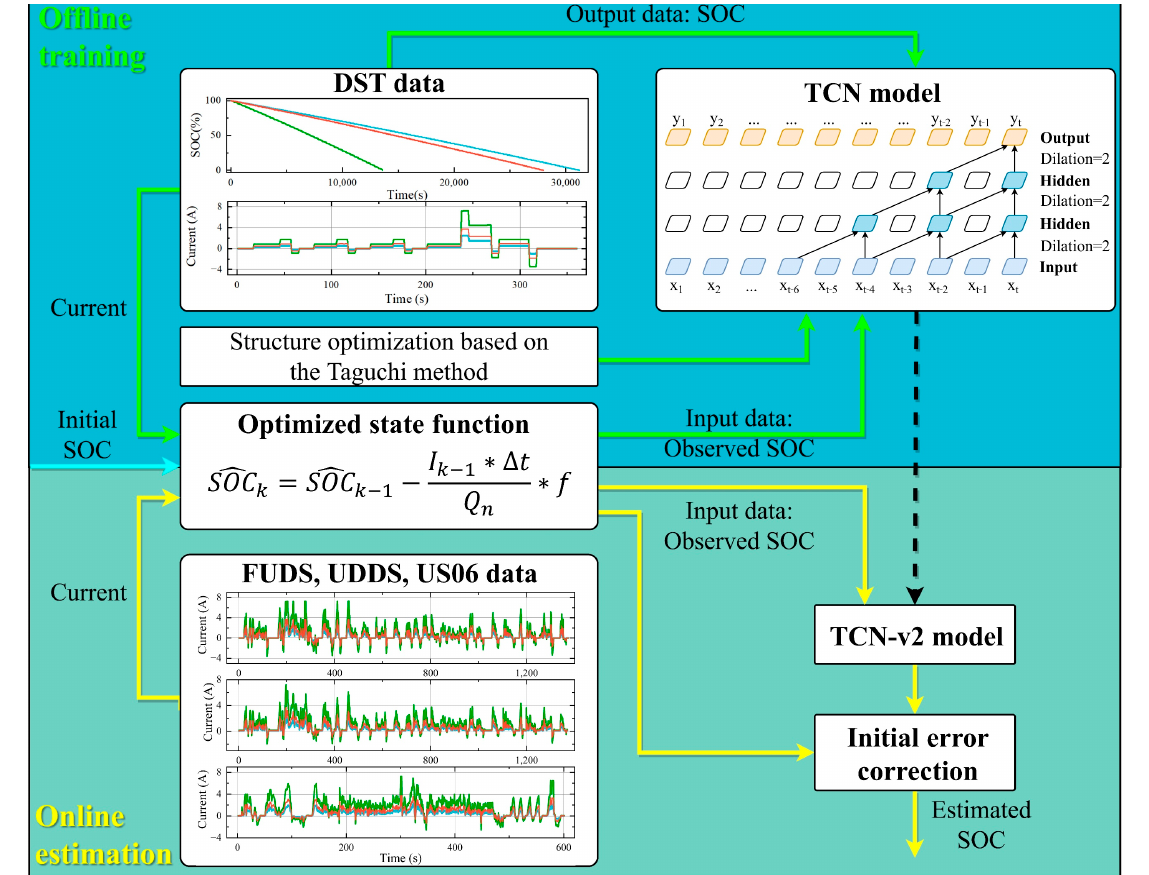
Figure 8. Graphical description of the proposed ATCN-v2 model.